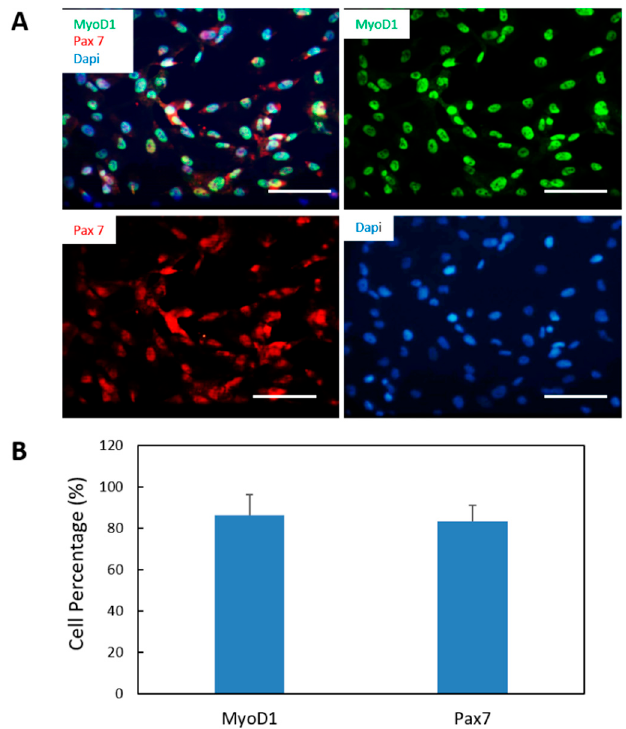
Figure 2. Characterization of myogenic progenitors differentiated from iPSCs. ( A ) Myogenic progenitors differentiated from iPSCs were expanded and immunostained for the myoblast markers MyoD1 (green) and Pax 7 (red). ( B ) Quantification of the percentages of MyoD1-postive cells and Pax7-positive cells out of the total number of cells (visualized by DAPI based on the immunostaining from A. Over 15 images were randomly taken and analyzed for each coverslip. Three coverslips from three different batches of experiments were analyzed. Data presented are mean ± SEM. Scar bars: 100 µ m.